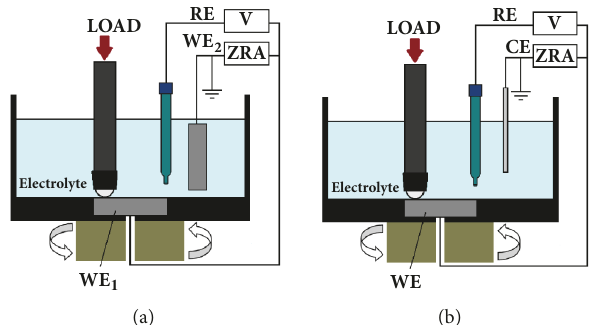
Figure 11: Schematic setup configuration for potential and current noise registration using: (a) two nominally identical electrodes and (b) asymmetrical